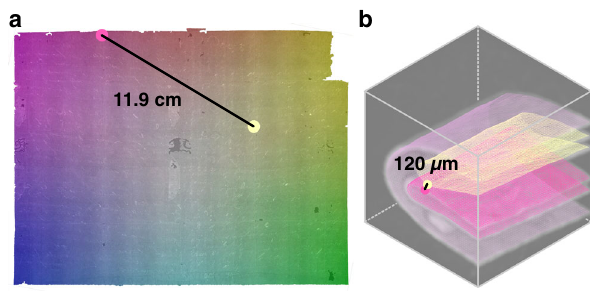
Fig. 5 Distance map applied to 2D and 3D embeddings. Colored 2D distance map of the a fl attened reconstruction of DB-1538 (same as Fig. 2c), and the same colormap applied to b a cropped section of the 3D folded state demonstrates that nearby vertices in 3D may be very far apart from each other in 2D, if they belong to different layers of the writing substrate. Distance metrics from the 2D and 3D embeddings of the mesh are used during hybrid mesh propagation to enforce global developability of the fi nal result.